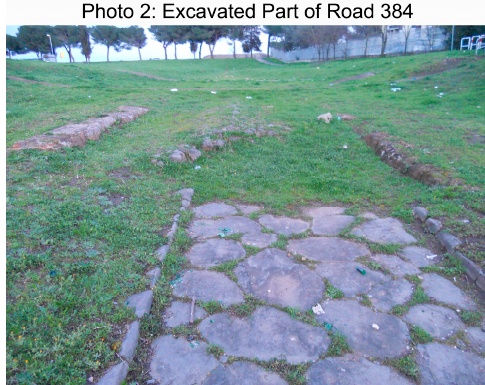
Figure 33. Photograph acquired of the part of Road 384 that was excavated during the construction of Tor Bella Monaca in the 1980’s. Two phases of development can be seen from the two layers of paving and different widths. The photograph was acquired on 16 March 2013 at 18:27 CET.